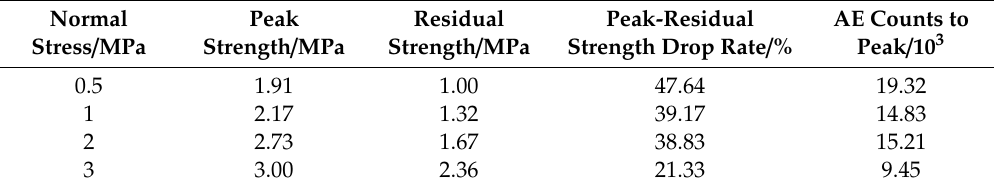
Table 3. Relationship between peak-residual strength drop rate and AE counts in scheme